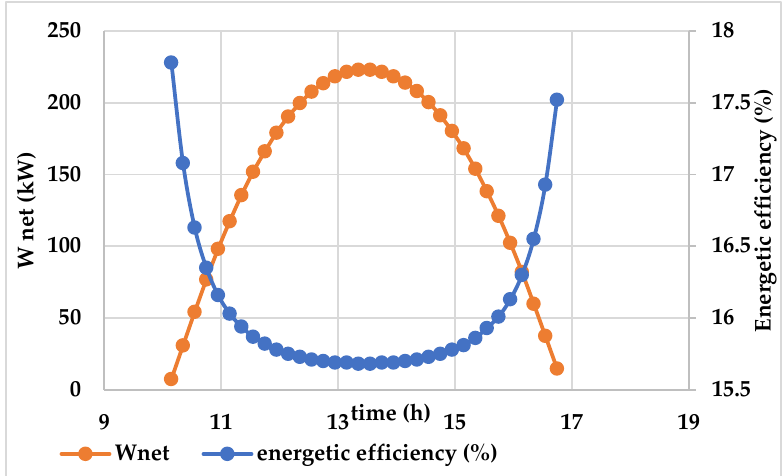
have an inverse relationship.